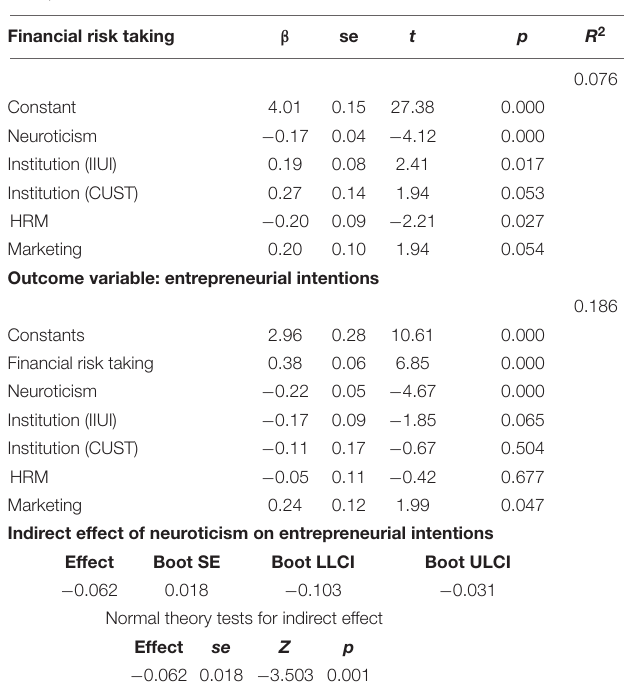
TABLE 5 | Mediating role of financial risk taking between neuroticism and entrepreneurial